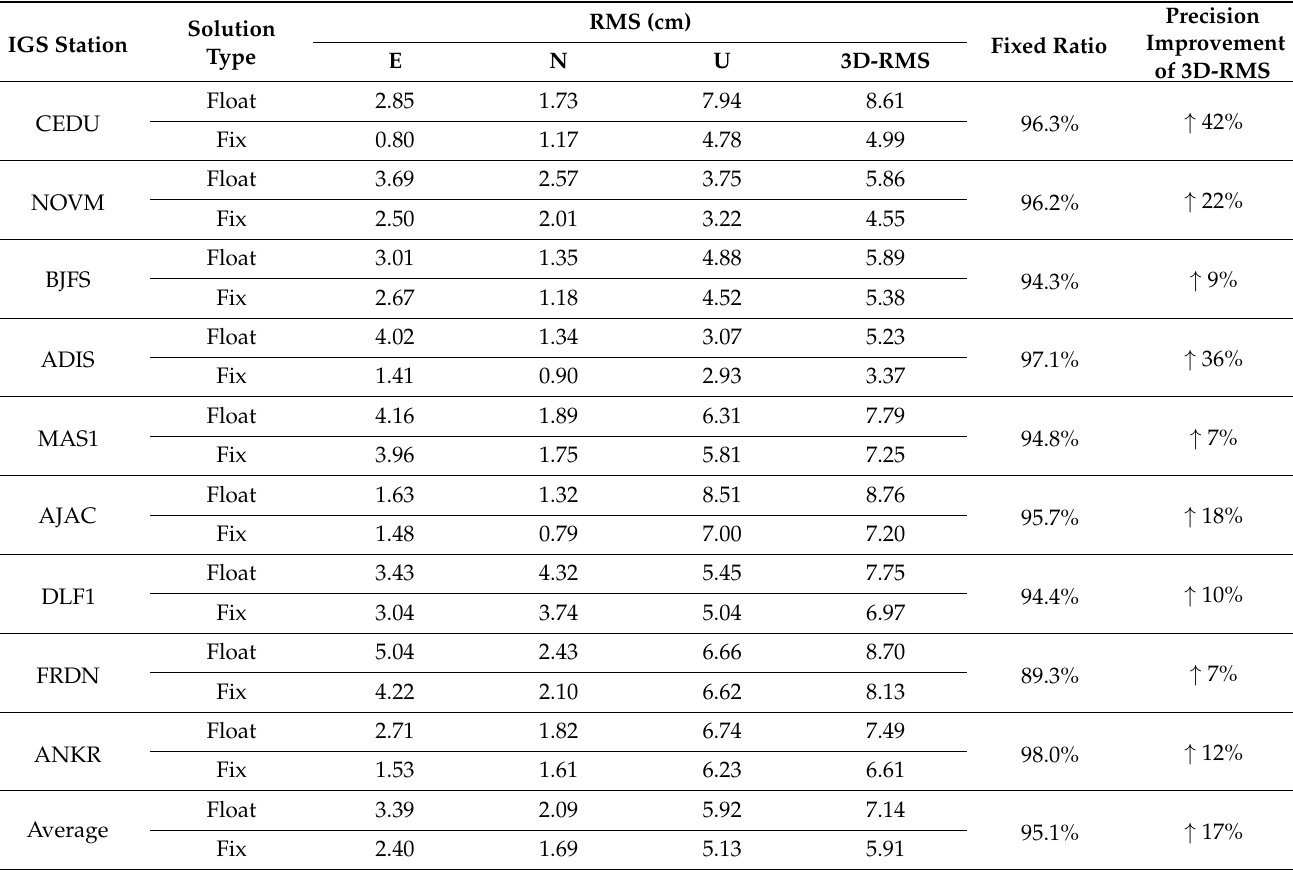
Table 2. The ambiguity-fixed ratio and RMS of real-time PPP in E (east-west), N (north-south), and U (up-down) directions and 3D-RMS (total position error) with different solution